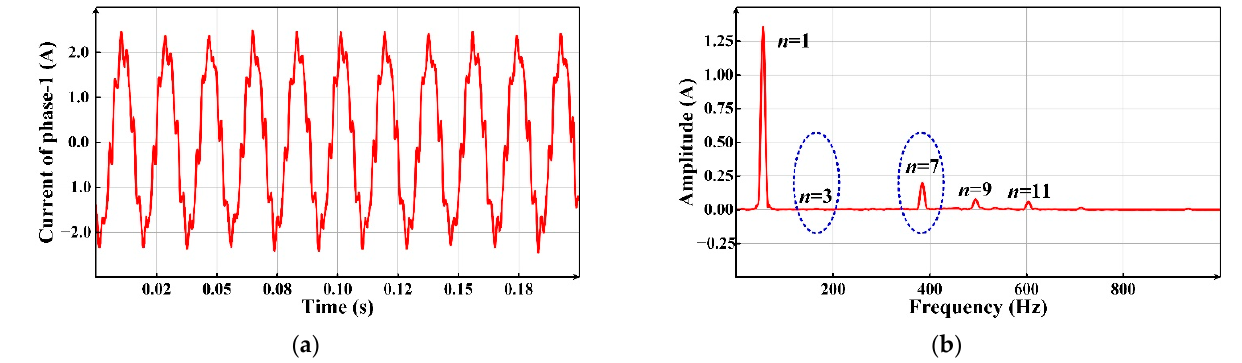
Figure 10. Harmonic current suppression results with fundamental currents and third harmonic current: ( a ) phase-1 current; ( b ) DFT results.